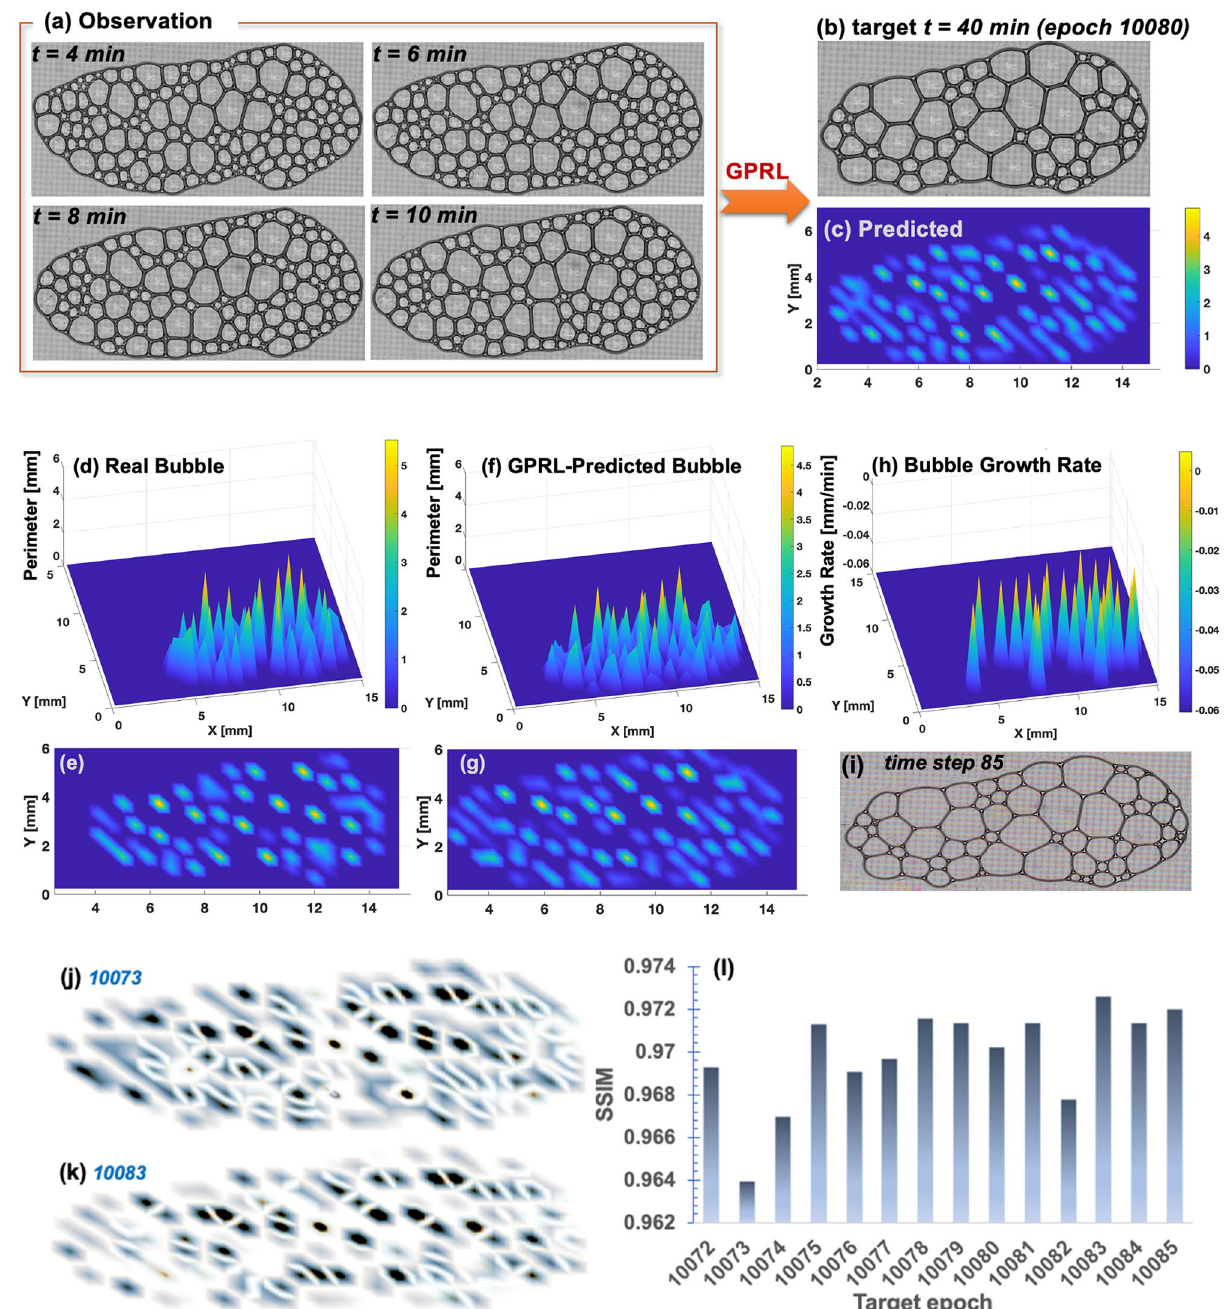
Figure 3. Long-term prediction by the best-so-far rules from GPRL with elongated bubble array: ( a ) shows four real bubble arrays fed into training by GPRL. Only four observed snapshots 2 min apart are needed for training of GPRL; ( b ) Snapshot of the 30 min later target; ( c ) Simulated perimeter distribution of bubble array at the target time step predicted by the best-so-far rule of GPRL (MAE = 0.221856); ( d ) and ( e ) are real bubble arrays from bird’s-eye view and plan view, respectively; ( f ) and ( g ) are simulated bubble arrays (MAE = 0.20493); ( h ) Best-so-far bubble growth rate; ( i ) Snapshot of the real bubble array of the elongated specimen at the time step 85. The GPRL predictions during all training require four observed snapshots 2 min apart to predict bubble 30 min later; ( j – k ) Local structural similarity (SSIM) index map of target epoch 10,073 ( j ) and 10,083 ( k ) in which white-colored pixel indicates perfect similarity between real and predicted bubble images whereas black color indicates difference; ( l ) Gradual improvement of global SSIM approaching 1.0 (i.e., identical images) as the Bayesian evolution takes place over 14 target